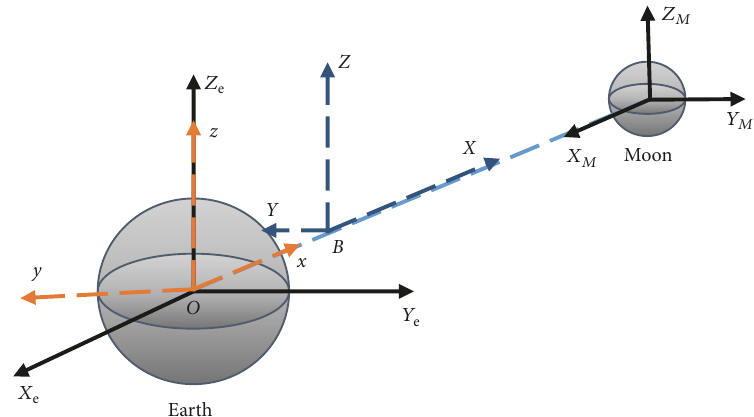
Figure 1: The J2000 coordinate system and the geocentric rotating coordinate